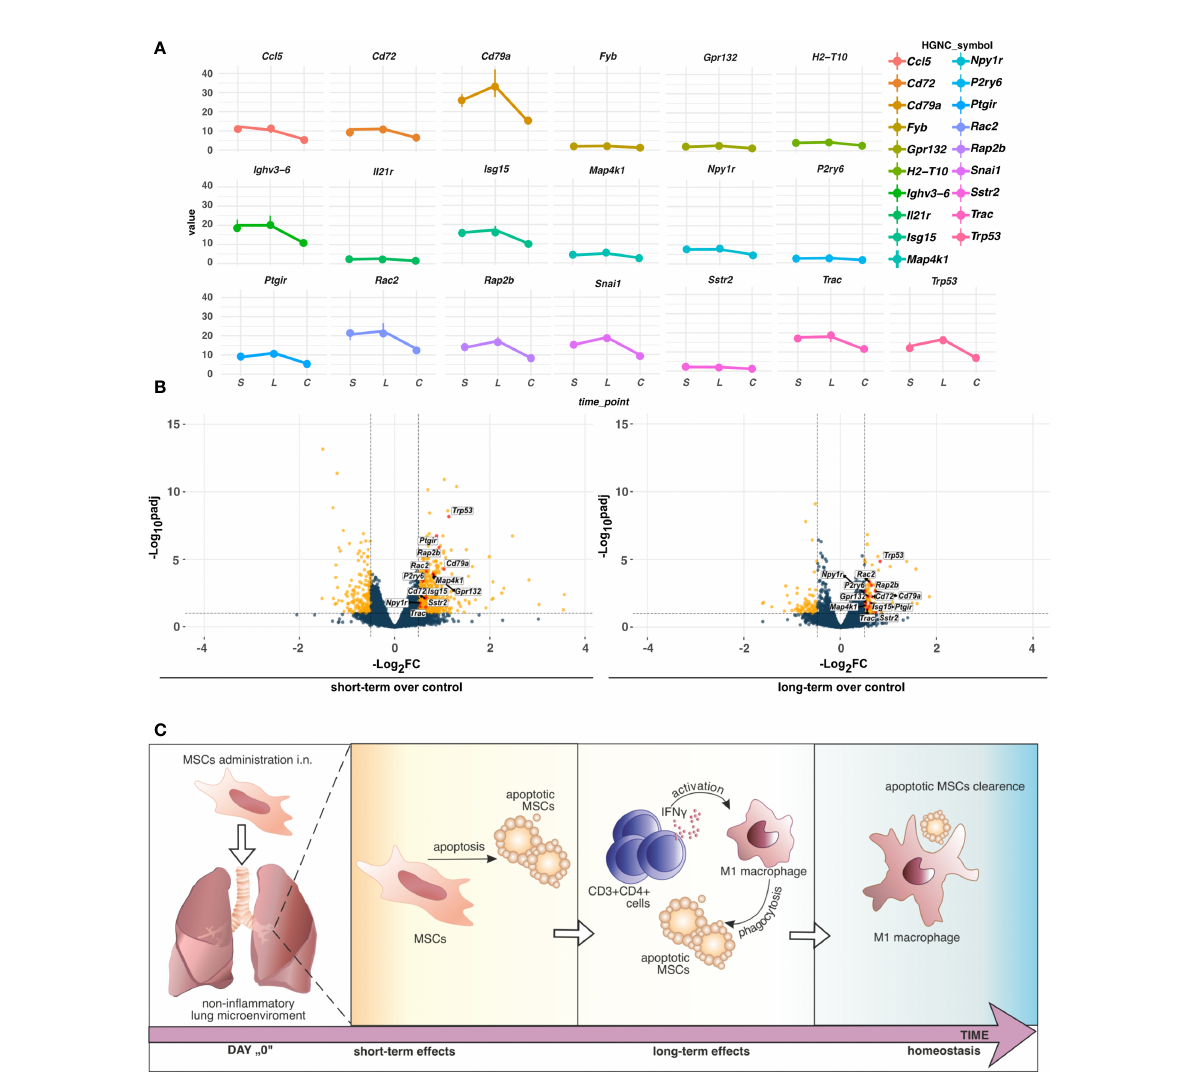
FIGURE 6 (A) TPM differences of genes altering the z-scores of pathways indicated by IPA. Dots represent the median (n=5) values of TPM in the group, short-term ( S), long-term (L), or control (C) . Vertical lines connected to the dots indicate the upper (Q3) and lower (Q1) quantiles. (B) Distribution of the commonly regulated genes in short-term and long-term models. Commonly regulated genes in short- and long-term models altering the z-scores of pathways in IPA were marked red. Yellow dots refer to unique DEGs, whereas dark blue indicates no cutoff criteria met. Dashed horizontal and vertical lines represent the cutoffs for adjusted p-value (BH) < 0.1 and absolute Log2FoldChange > 0.5, respectively. (C) The proposed hypothesis of MSCs fate in the non-in fl ammatory microenvironment in the lungs. In non-in fl amed lungs, MSCs undergo apoptosis which induces low-grade in fl ammation. An increase in IFN g producing CD3 + CD4 + cells activates phagocytic M1 macrophages to clear apoptotic